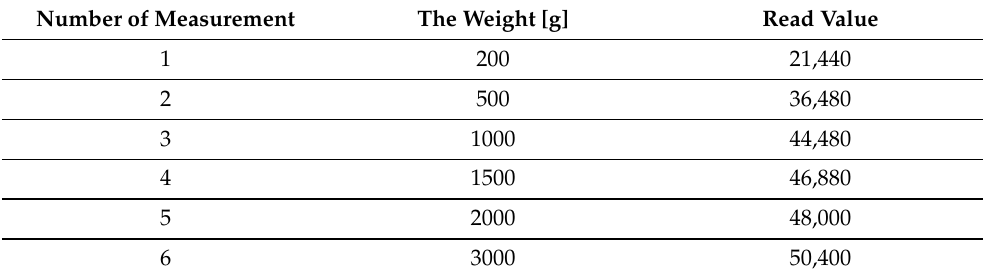
Table 3. Table of measurements after averaging the values.